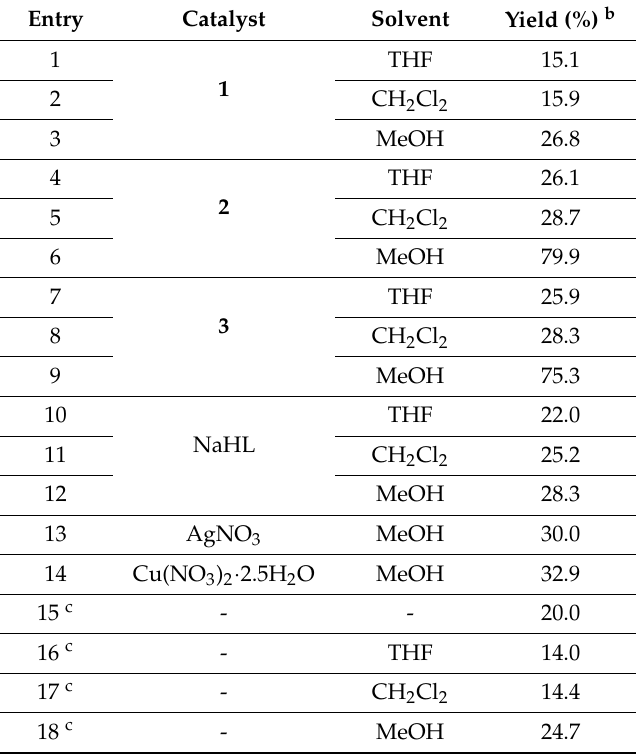
Table 2. Catalyst and solvent screening for the cyanosilylation of benzaldehyde a . Entry